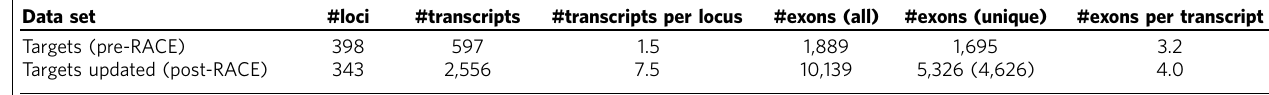
Table 3 | Table summarizing basic annotation statistics before and after RACE-Seq. Data set Targets (pre-RACE) RACE, rapid amplification of cDNA ends. Unique exons are those having distinct coordinates on the genome. The number of previously unannotated unique exons is indicated between parentheses in the penultimate